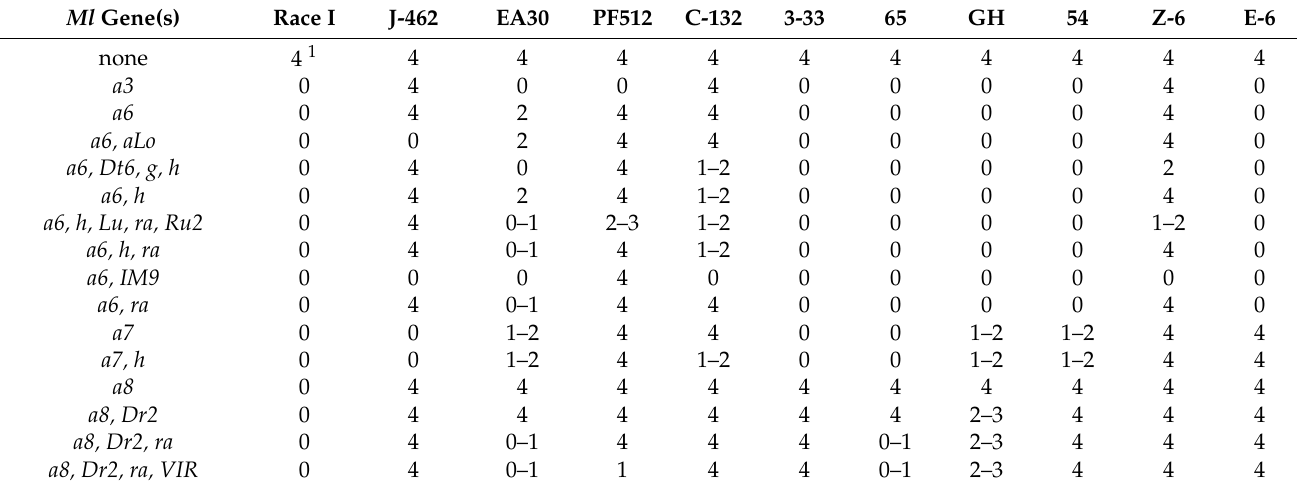
Table 1. Infection response arrays produced by 11 Blumeria graminis f. sp. hordei isolates on 71 barley genotypes and their powdery mildew resistance